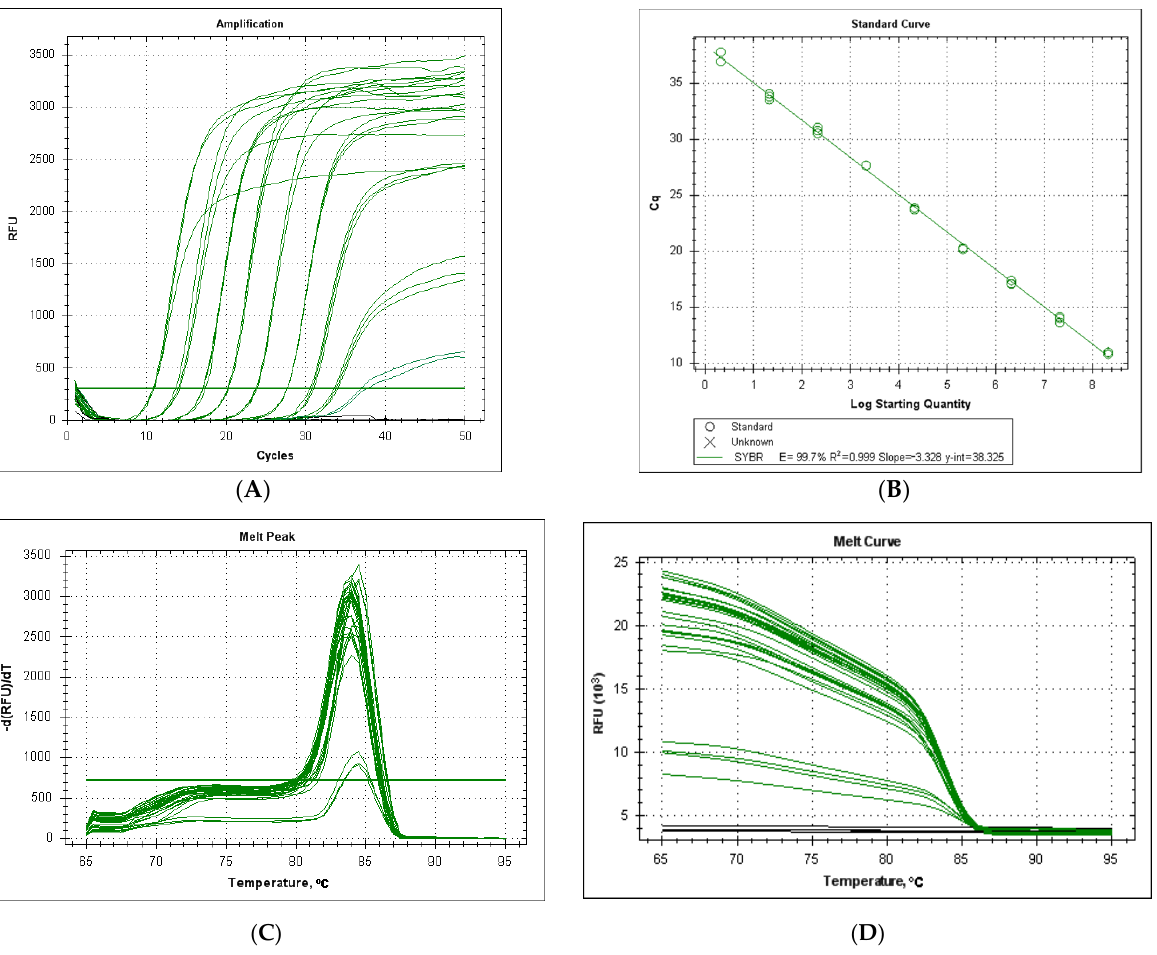
Figure 2. ( A ) Serial dilution from 2.1 × 10 8 to 2.1 x 10 0 copies per reaction. Black lines correspond to negative samples (2.1 × 10 − 1 and 2.1 × 10 − 2 copies per reaction). ( B ) Standard curve from 2.1 × 10 8 to 2.1 × 10 0 copies per reaction. ( C ) Melt point analysis for 36 reactions with 2.1 × 10 8 to 2.1 × 10 0 copies. ( D ) Melt curve analysis for 36 reactions with 2.1 × 10 8 to 2.1 × 10 0 copies.